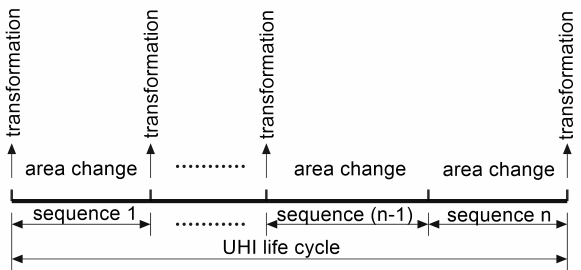
Figure 3: Timeline of an